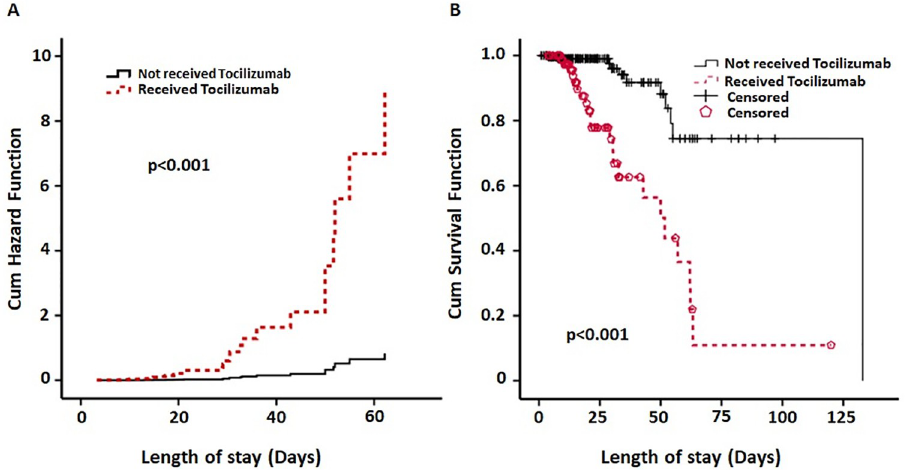
Fig 1. A . Cox regression curve shows cumulative hazards function of Tocilizumab in developing pneumothorax during time of admission after adjusting for significant covariates. The black curve represents patients who did not receive tocilizumab and the red dotted curve represents patients who received tocilizumab. There was a significant difference (chi square test, p < 0.001) between subjects who received tocilizumab and who didn’t. B . Kaplan-Meier survival curve shows cumulative probability of survival function of pneumothorax in two cohorts of tocilizumab and non-tocilizumab with known outcome up to 25 days of hospitalization. The black curve represents patients who did not receive tocilizumab and red dotted curve depicts patients who received tocilizumab. Survival function curves of pneumothorax are statistically different between two group based on receiving tocilizumab (log rank test, p < 0.001) during time of